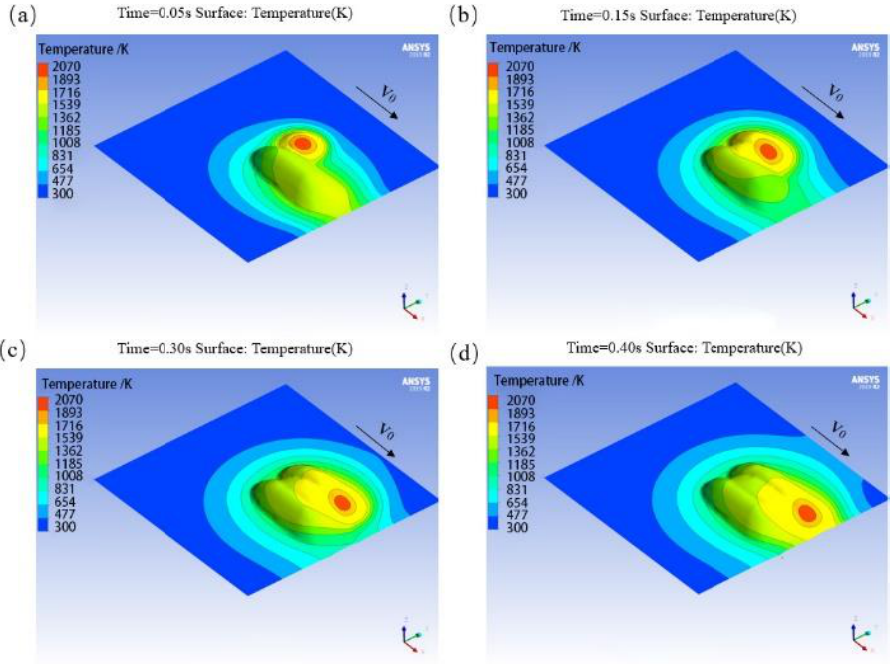
Figure 15. Temperature distribution at different moments from the beginning of overlapping. ( a ) 0.05 s; ( b ) 0.15 s; ( c ) 0.30 s; ( d ) 0.40 s.